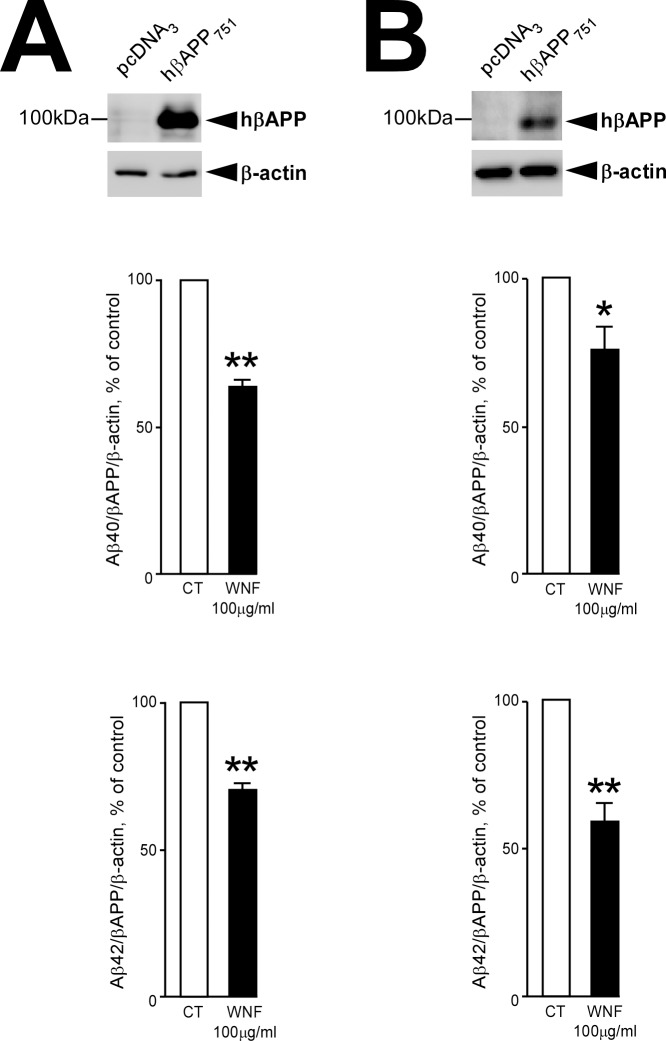
WNF decreases Aβ peptides generation in HEK293 and SH-SY5Y human cells.HEK293 (A) and SH-SY5Y cells (B) transiently transfected with human wild-type βAPP751 for 36 hours were incubated in the absence (white bars) or in the presence (black bars) of WNF (100μg/ml) during the last 16 hours in 600μl of DMEM/1% FBS. Proper βAPP overexpression was assessed by western blot (upper panels) and human Aβ40 and Aβ42 were measured in 50μl of the 16 hours-secretion media by ELISA. Data are presented after normalization to βAPP and β-actin, values in black bars are expressed as the percent of control (no treatment, white bars) and are the means ± SE of 6 independent determinations. *p<0.02; **p<0.0001.